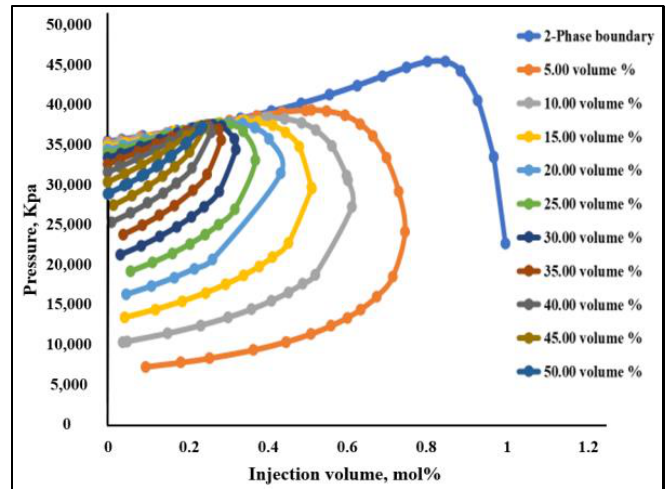
Figure 12. P-X phase diagram of the original formation fluid.